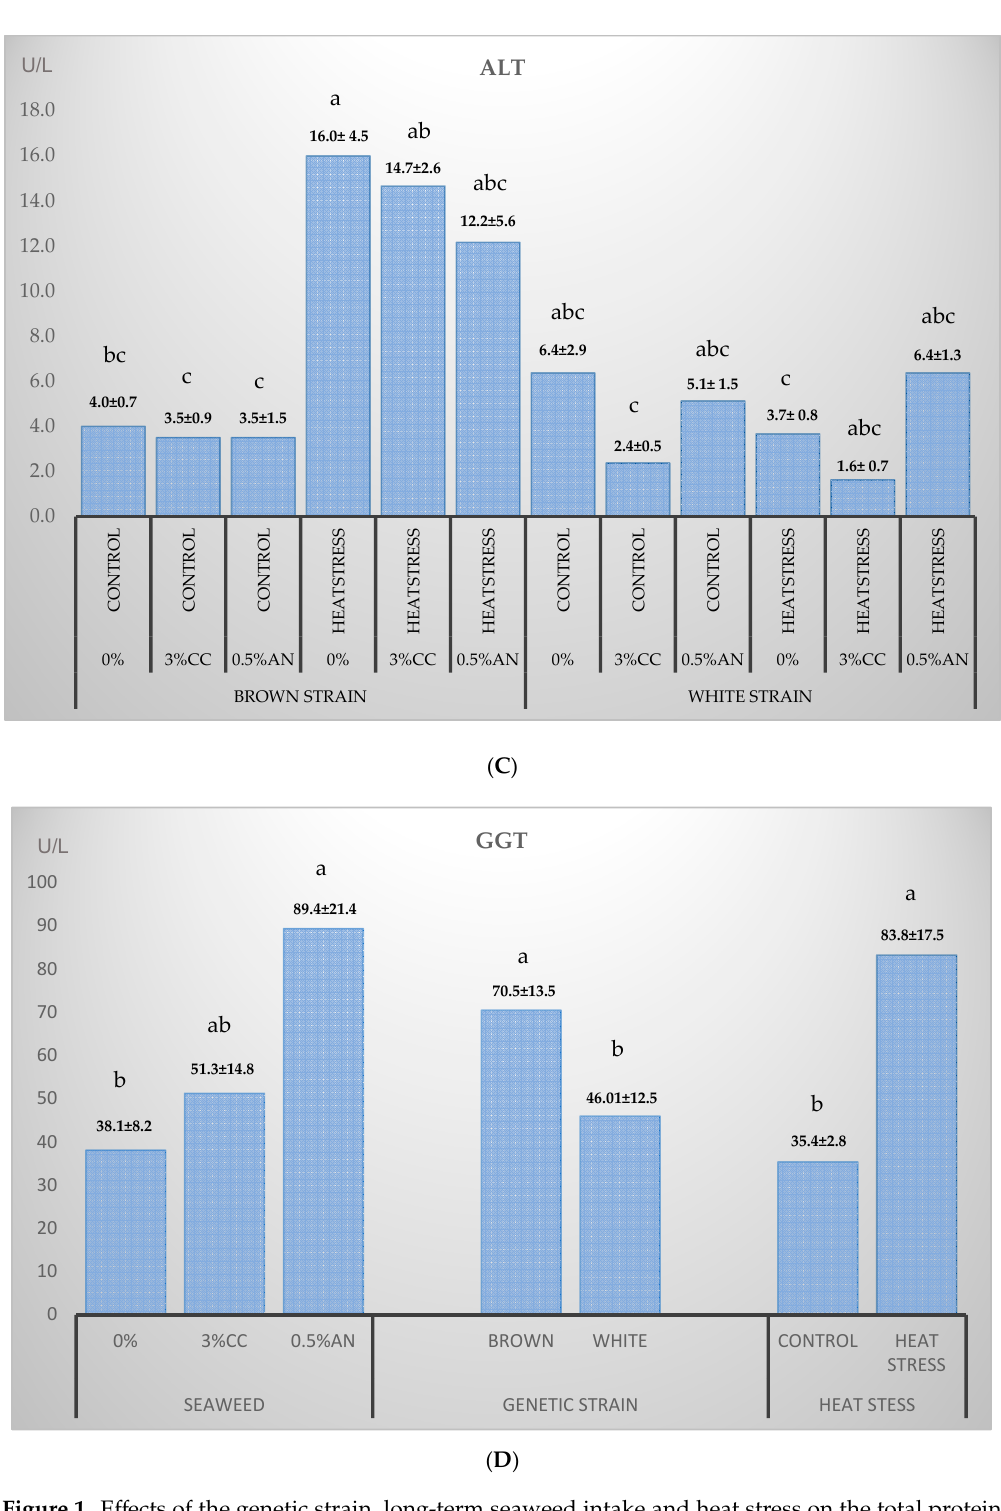
Figure 1. Effects of the genetic strain, long-term seaweed intake and heat stress on the total protein ( A ), globulin ( B ), alanine aminotransferase (ALT) ( C ) and gamma-glutamyl transferase (GGT) ( D ) in layer hens ( p -value < 0.05). Values are least squares means ± standard error. a,b,c: Bars with different letters were different according to the Tukey means comparison test ( p < 0.05). CC: Chondrus crispus. AN: Ascophyllum nodosum.